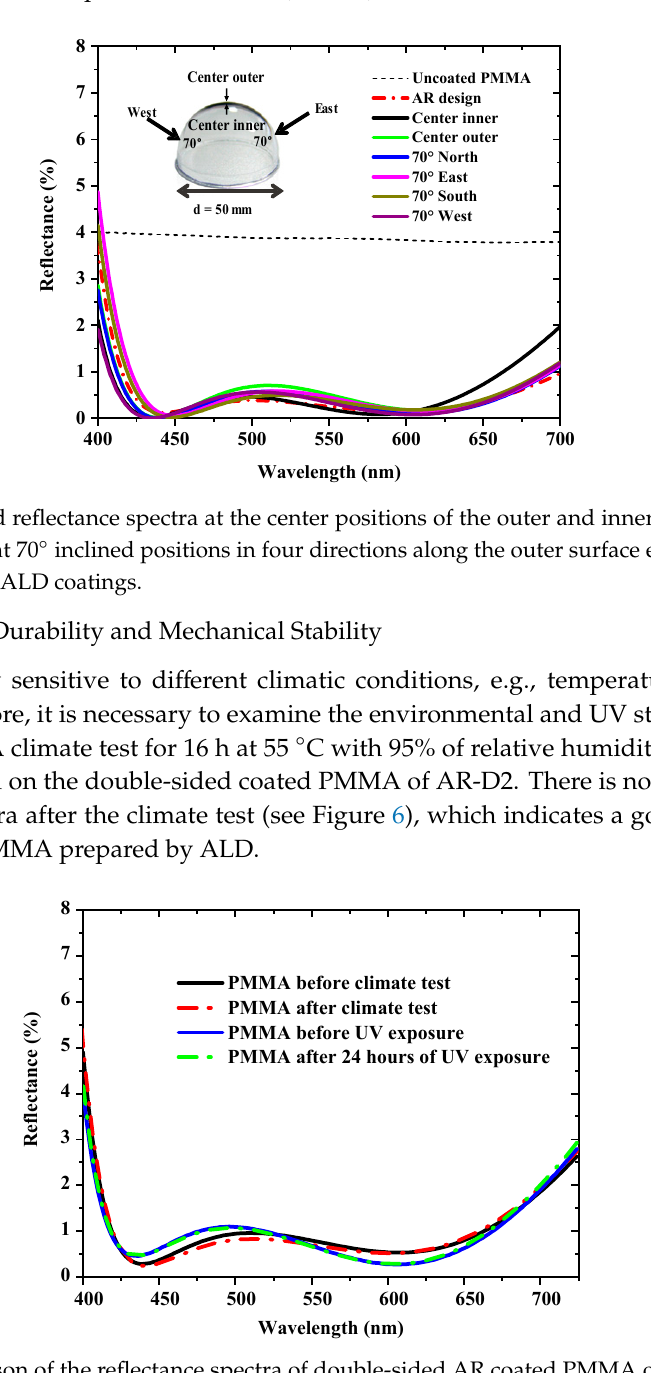
Figure 6. Comparison of the reflectance spectra of double-sided AR coated PMMA of AR-D2 before and after climate test and before and after 24 h of UV exposure.